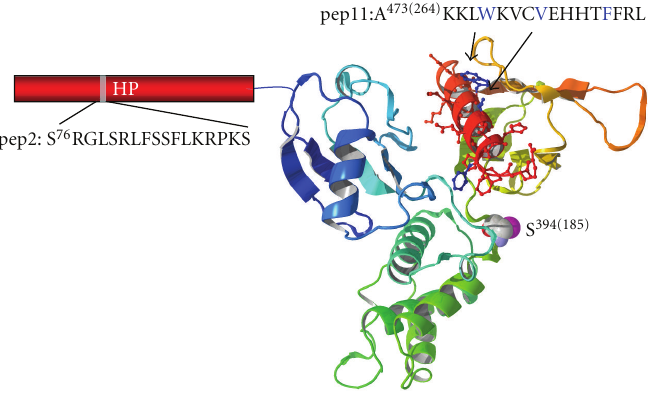
Figure 5: Mapping of the CaM-binding sites in 4.1R. 4.1R 135 has three CaM-binding sites: pep2 in the HP region, S 185 being the key residue for Ca 2+ -sensitive site, and Ca 2+ -independent sequence; pep9 and pep11 in the FERM domain. Numbers in parenthesis indicate amino acid numbering for 4.1R 80 (AUG2 form in Figure